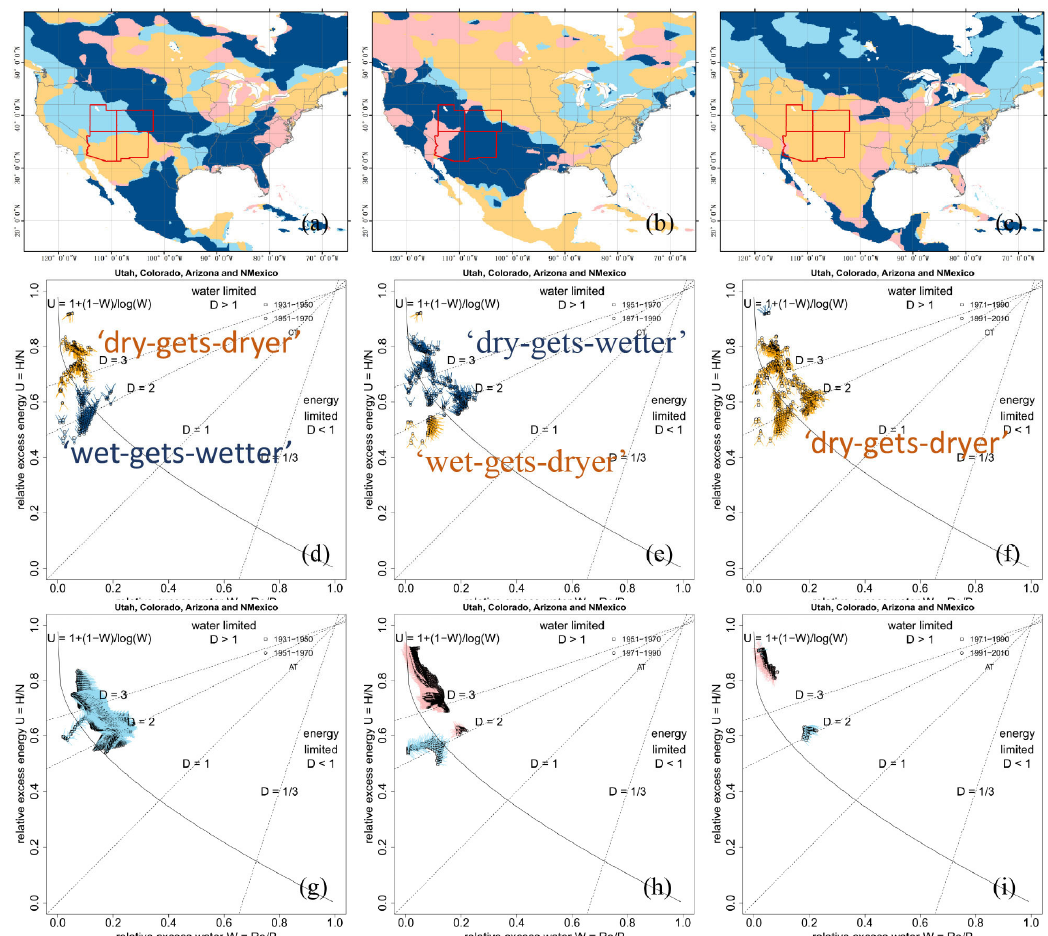
Figure 4. Ecohydrological attribution analysis for the southwestern states of Arizona, Colorado, New Mexico, and Utah (step 1): geographical distributions of the four quadrants of attribution depending on the 20-year time changes from 1931–1950 to 1951–1970, 1951–1970 to 1971–1990, and 1971–1990 to 1991–2010 (1st row, ( a – c )) as well as trajectories of changes in excess energy and water (U,W) for external climate forcing (2nd row, ( d – f )) and for land cover-induced (internal) forcing (3rd row, ( g – i )). In general, the climate change trajectories (dark blue and yellow arrows), like “dry-gets- drier” and “wet-gets-wetter” dipole, are displayed in ( U,W ) state space and